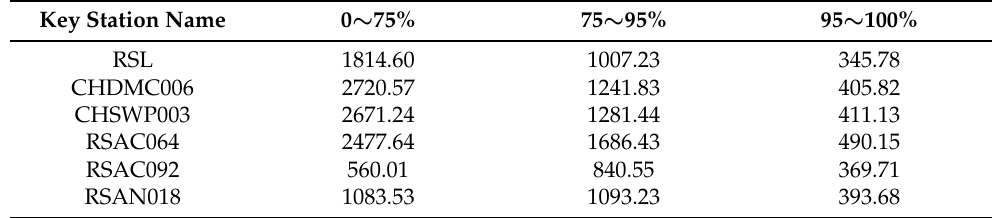
S t for six key stations. S t t = 1 ref